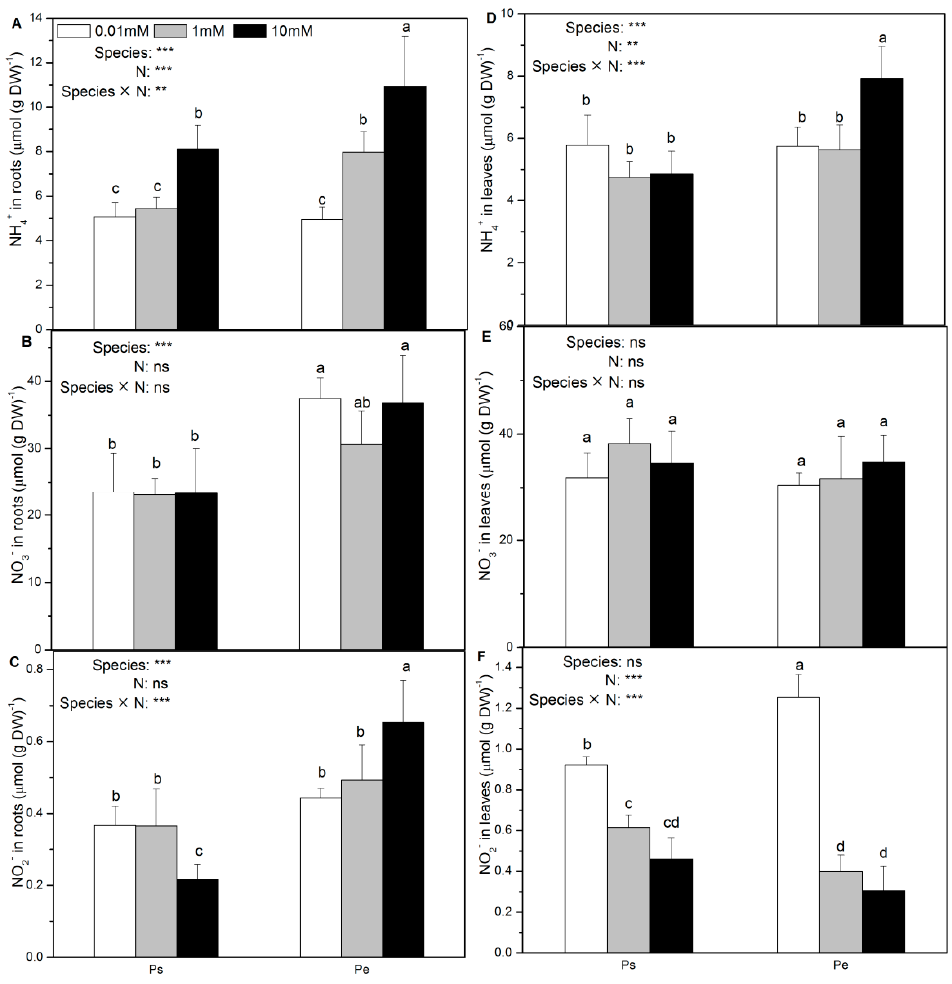
Figure 5. NH 4+ ( A , D ), NO 3 − ( B , E ), and NO 2 − ( C , F ) concentrations of P. simonii (Ps) and Populus euramericana (Pe) under 0.01, 1, and 10 mM NH 4 NO 3 . Bars labelled with different letters indicate significant difference between the treatments. p -Values of the ANOVAs of species, N treatment, and their interaction are indicated. ** p < 0.01; *** p < 0.001; ns, not significant.